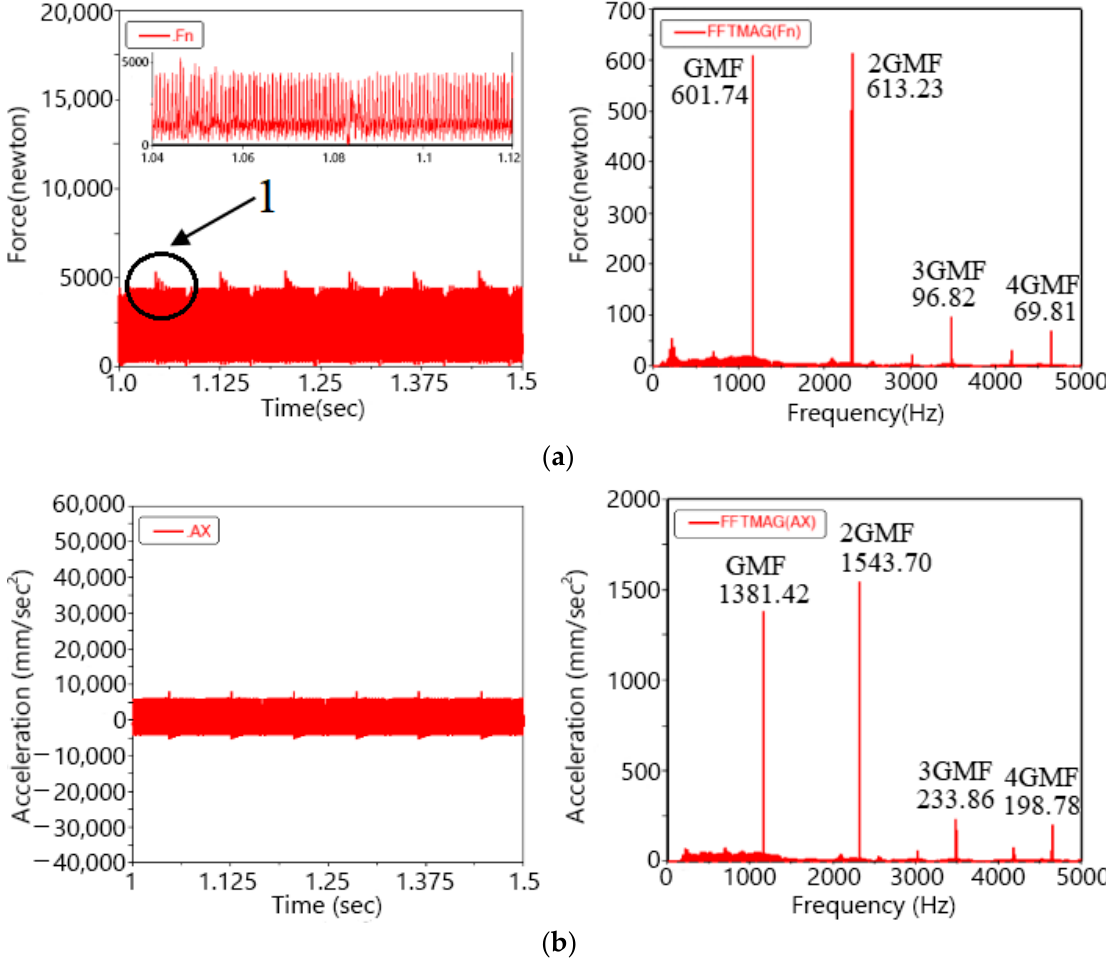
Figure 4. ( a ) Normal meshing force and ( b ) x-direction vibration acceleration.